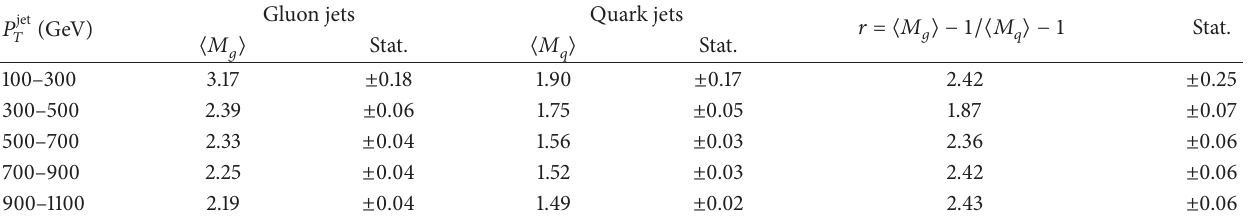
Table 5: Average subjet multiplicities (calculated using (7)) and ratio of subjet multiplicities (from (8)) in the phase space |𝜂| < 2 in different 𝑃 jet 𝑘 𝑇 algorithm. 𝑇 (GeV) bins for